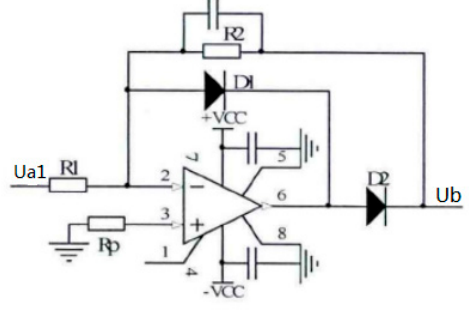
Figure 9. Synchronized envelope rectifier circuit.